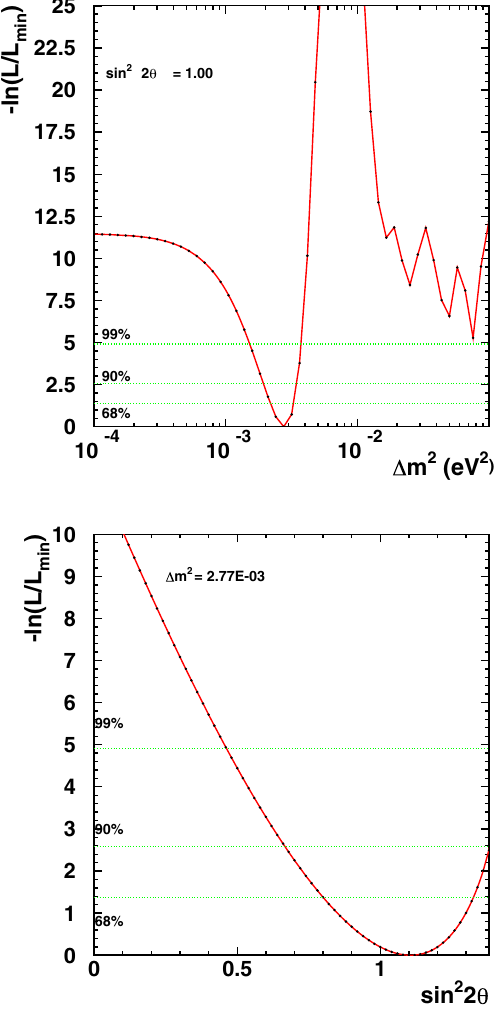
Fig. 34 ln L phys max − ln L (Δ m 2 , sin 2 2 θ) distribution as a function of Δ m 2 (top) and sin 2 2 θ (bottom), in which ln L phys max is the maximum value of L in physical parameter region. The sin 2 2 θ is set to be 1.00 in the top figure and Δ m 2 is set to be 2 . 76 × 10 − 3 eV 2 in the bottom figure. Three horizontal lines correspond to the 68%, 90% and 99% CL interval from the bottom one, respectively